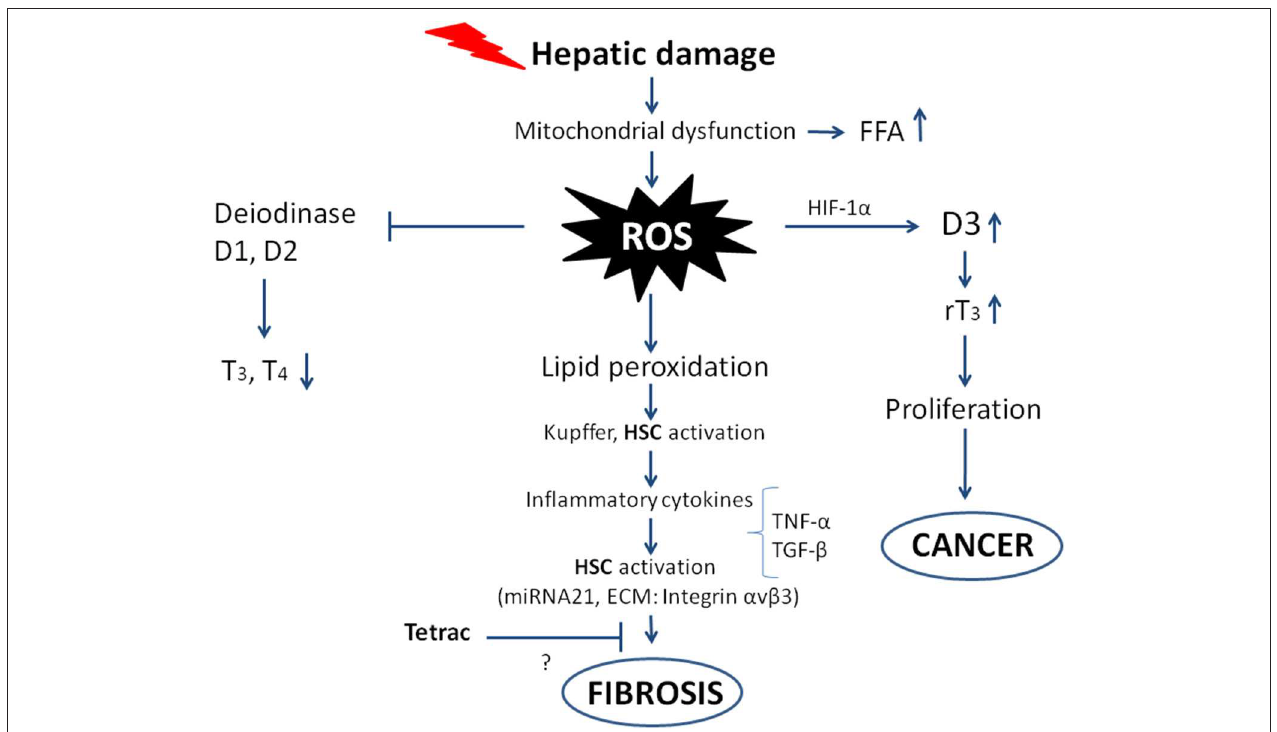
FIGURE 2 | Scheme showing the possible pathways from hepatic damage to fibrosis leading to cancer. The oxidative stress and ROS production follow mitochondrial dysfunction and hepatic damage. The direct consequences are impairment of deiodinase activity leading to decreased T3 production, on the other hand deiodinase 3 is imbalanced with increased activity and increased rT3, which stimulates the proliferation of tumor cells. The ROS produced give rise to inflammatory cytokines that increase the ROS and activate Hepatic Stellate Cells (HSC), leading to fibrosis and eventually cancer. The inhibition by tetrac of the fibrogenic process is only suggested as shown by the question mark, with integrin α v β 3 being among the ECM components involved in the “activation” of the Hepatic Stellate Cells.